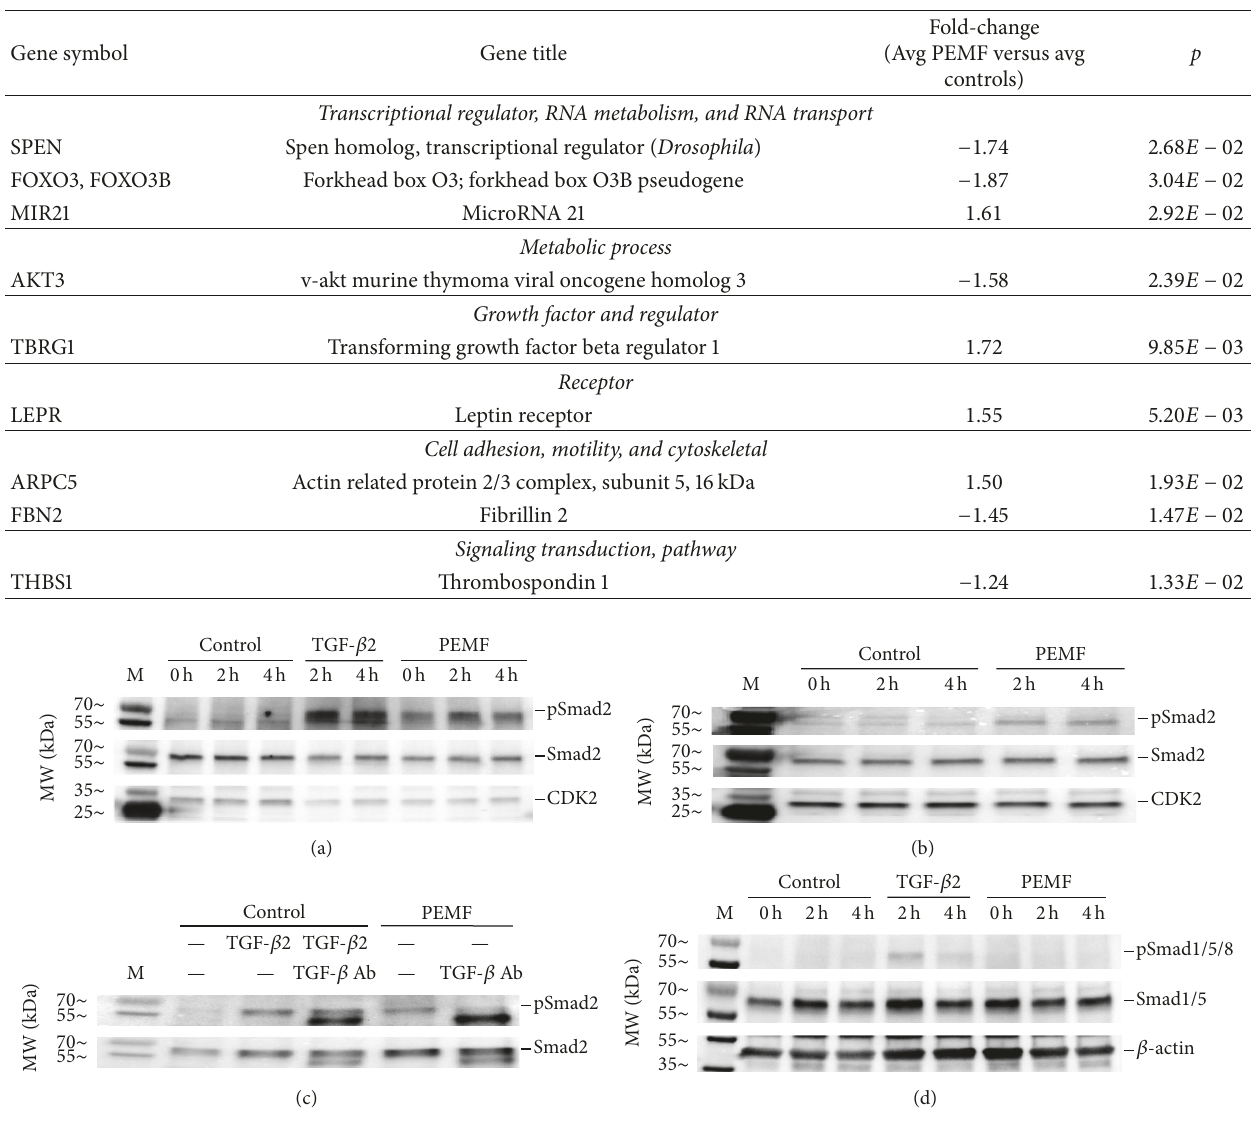
Table 3: Genes regulated by PEMF in differentiating hBMSCs. Cells were from a normal 27-year-old female. Total RNA was isolated at day 23 of PEMF treatment. Analysis by Student’s t- test.